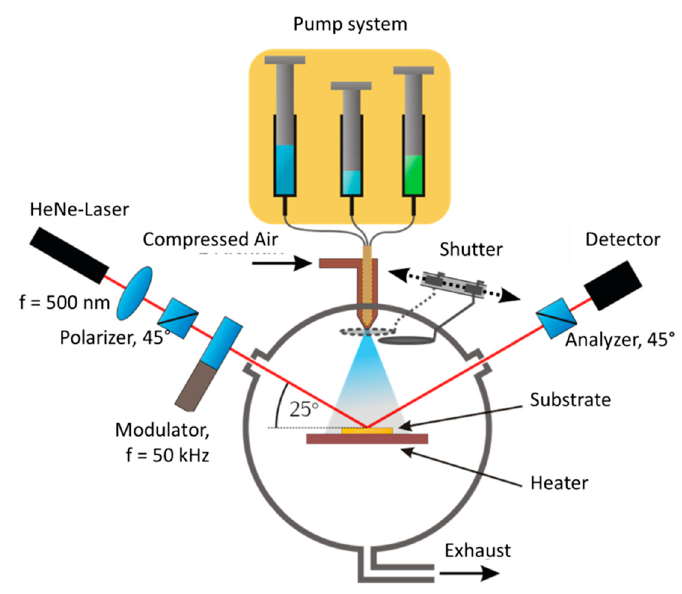
Figure 1. The scheme of the metalorganic aerosol deposition (MAD) apparatus equipped with a precision liquid pump system and in situ growth monitoring by means of optical ellipsometry. Reproduced from [28] with the permission of AIP Publishing.